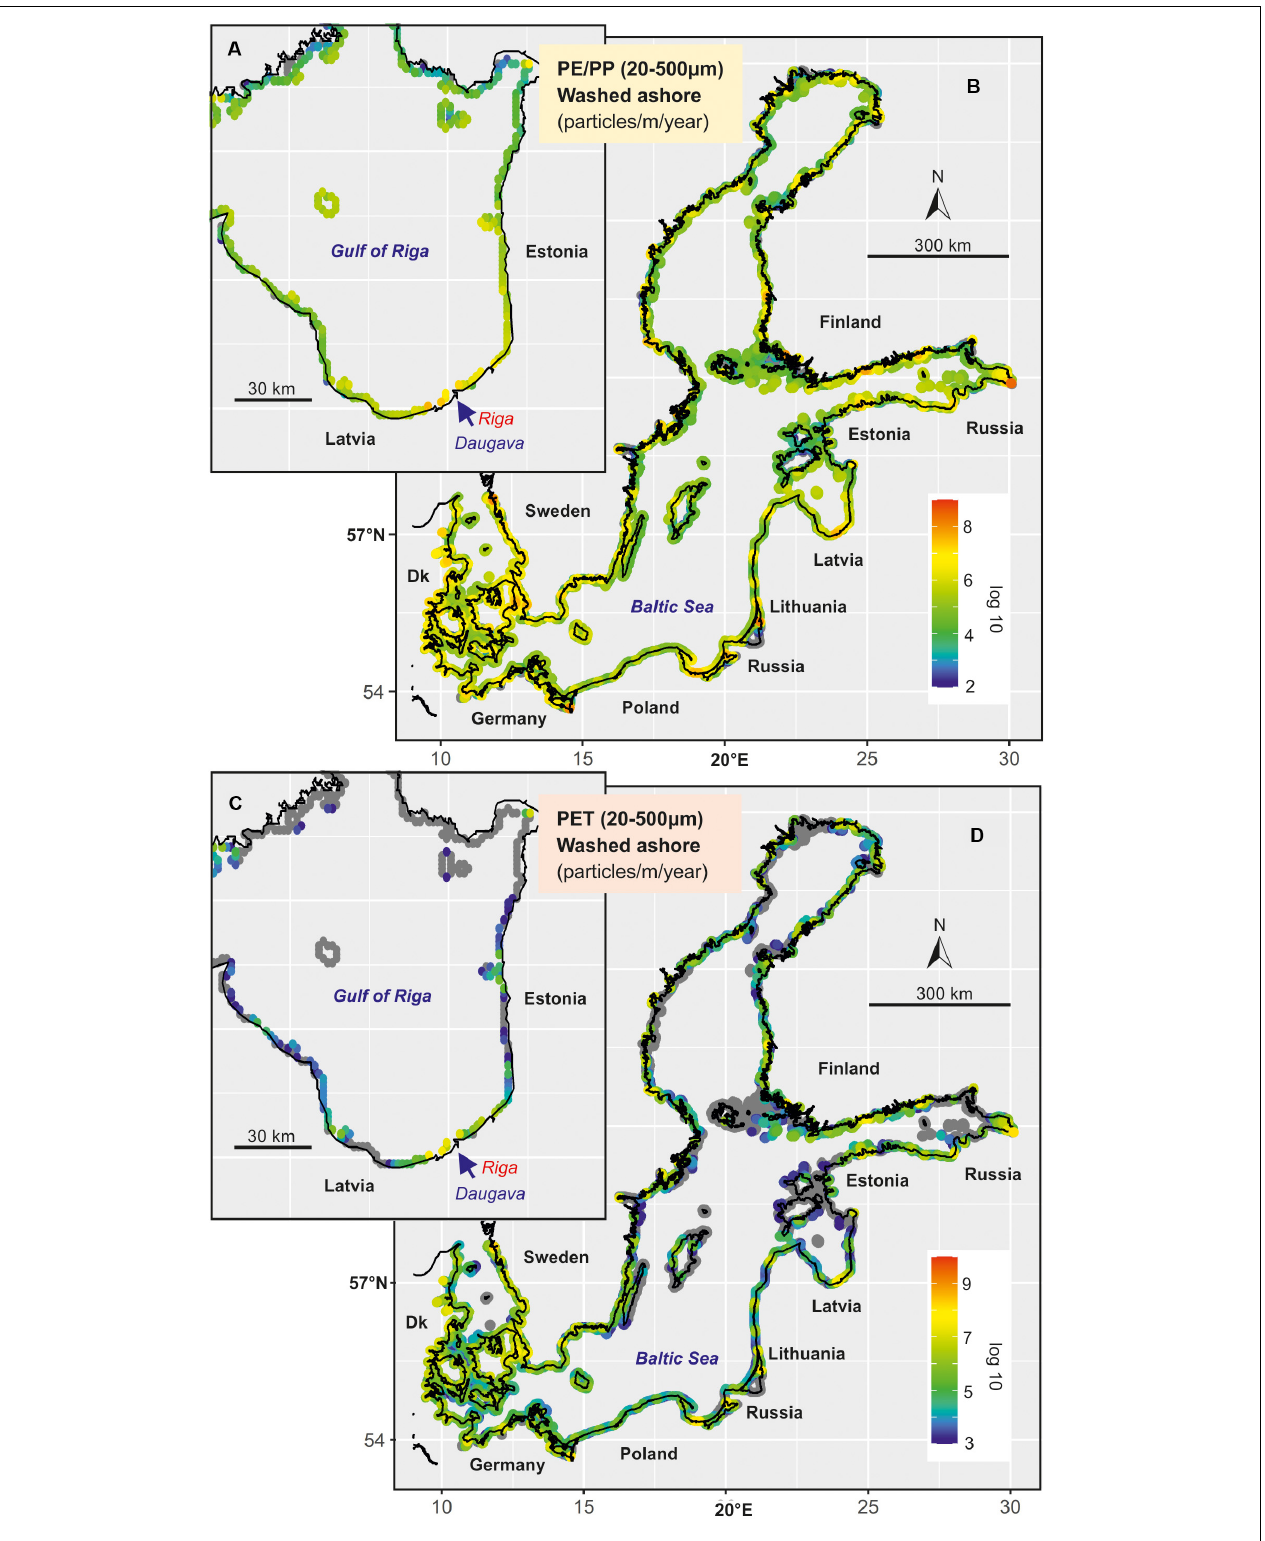
FIGURE 7 | Accumulation of Polyethylene (PE)/Polypropylene (PP) and Polyethylenterephthalat (PET) microplastic particles (20–500 µ m size fraction) at shores of the Baltic Sea (B,D) and in the Gulf of Riga (A,C) based on simulations with a 3D hydrodynamic model. PE/PP represents floating and PET sinking plastic. The emissions cover all three urban